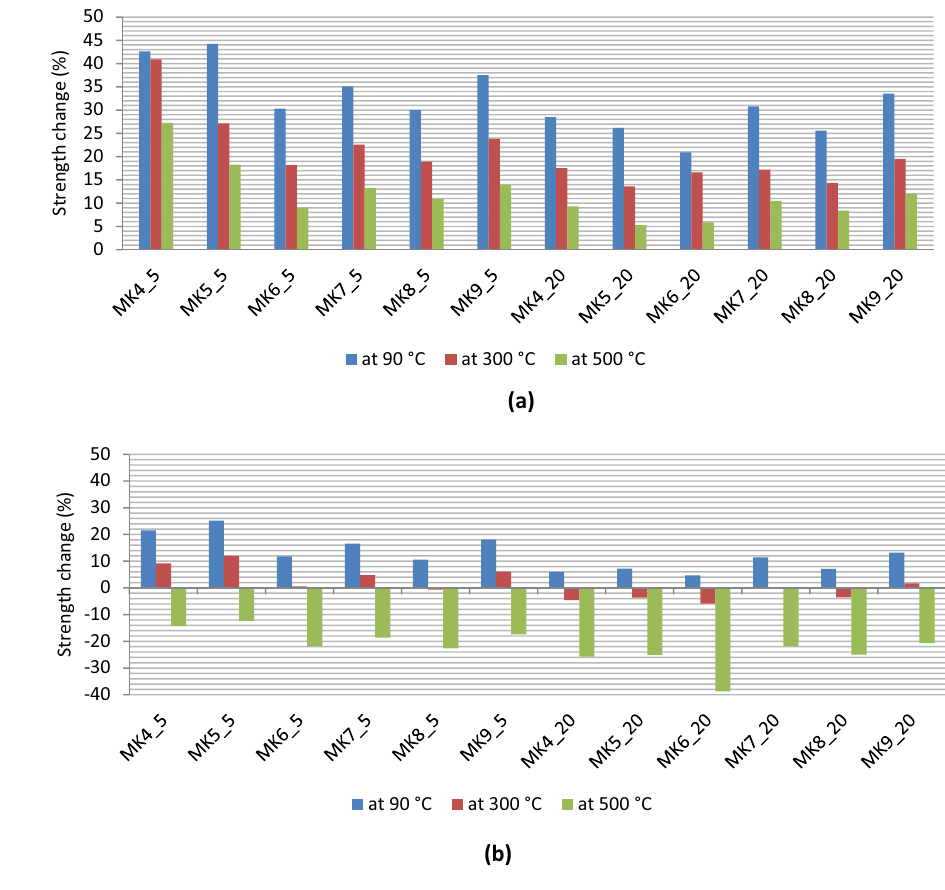
Fig. 7 Compressive strength evolution after exposure to elevated temperatures at a 7 days, b 56